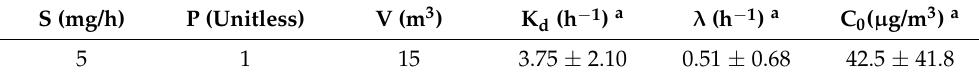
of 16.01 min measured in our labo- 2